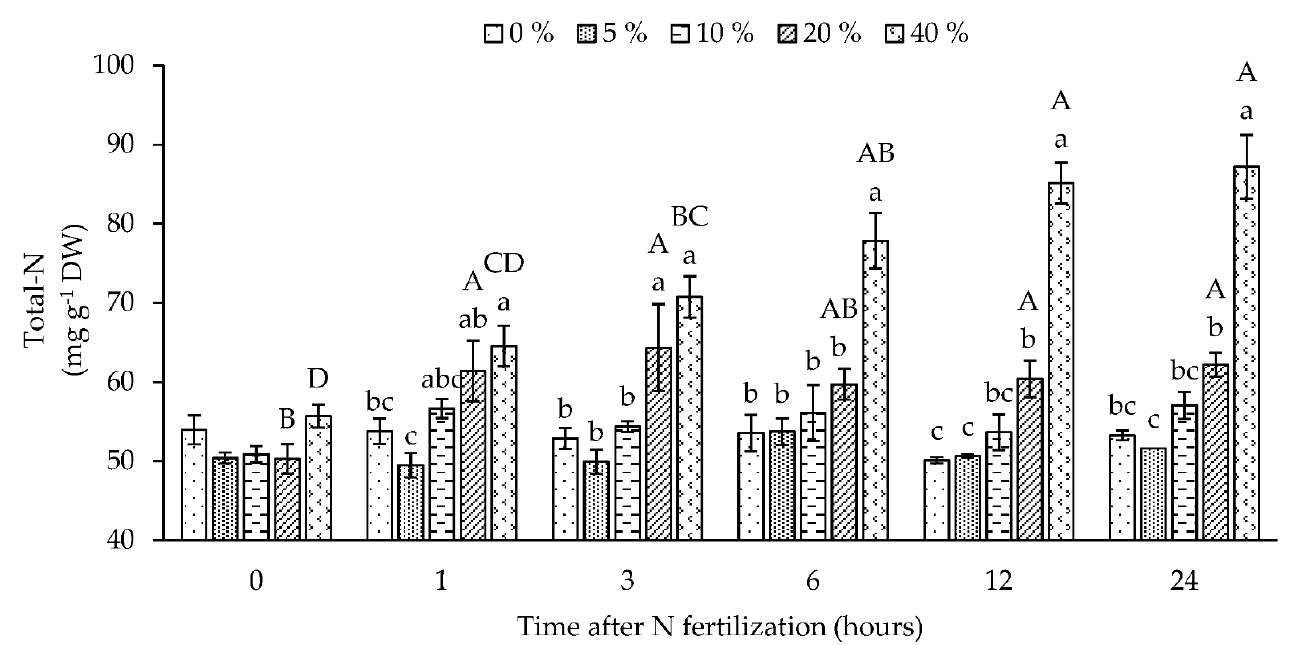
Figure 4. Total-N concentration of the youngest and second youngest fully expanded leaves of wheat (cv. Amaretto) at 0, 1, 3, 6, 12, and 24 h after the application of UAN solutions with increasing N concentration, namely 0, 5, 10, 20, and 40% N. Data are the means of three independent biological replicates ± standard error. Small letters indicate the difference between N treatments at each application time, and capital letters indicate the difference between application times for each N treatment according to Tukey’s post hoc test ( p < 0.05).